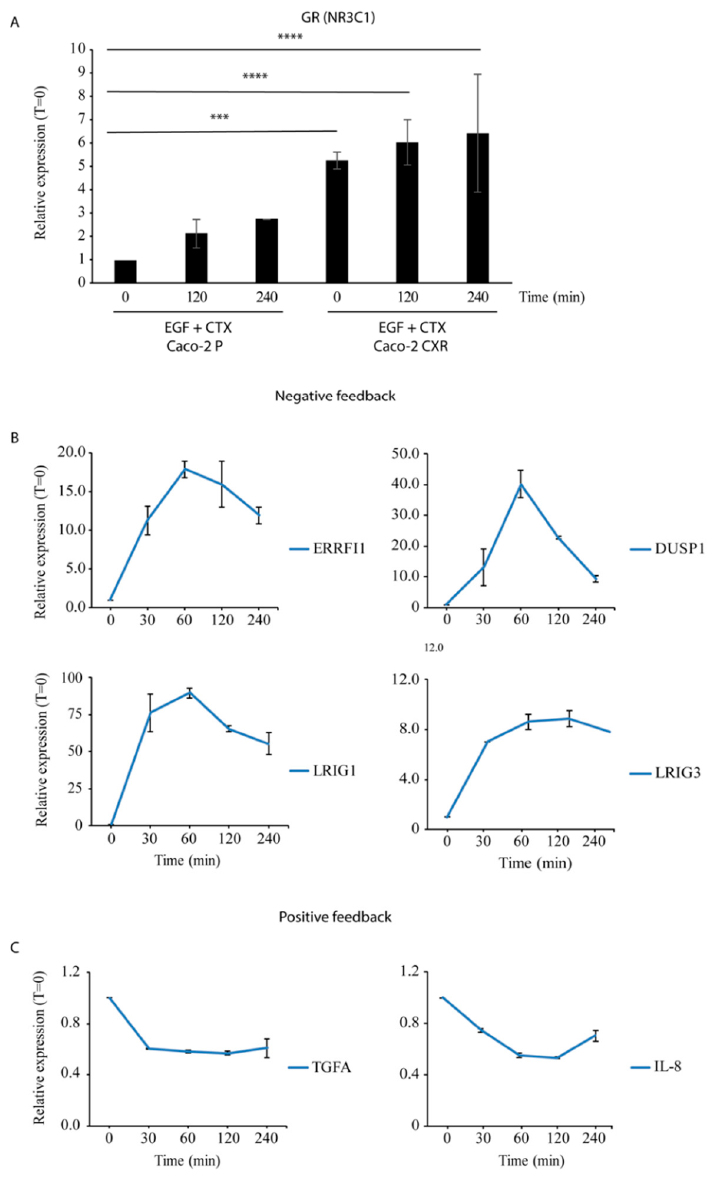
Figure 3. Dexamethasone suppresses EGFR positive regulators and boosts negative feedback loops in cetuximab (CTX) resistant cells. ( A ) Caco-2 Parental (P) and Caco-2 cetuximab resistant (CXR) cells were treated with cetuximab (CTX, 2 µ g / mL) in combination with EGF (20 ng / mL) for 120 and 240 min. Notably, Caco-2 CXR displayed a higher basal level of GR mRNA compared to Caco-2 P counterpart. We also observed an increase in GR mRNA production in both Caco-2 P and Caco-2 CXR, compared to time 0. The ordinary one-way ANOVA with Dunnett’s multiple comparisons test was applied to evaluate statistical changes in relation to Parental cells to time 0. **** p < 0.0001 and *** p < 0.0005. ( B ) Caco-2 CXR cells were pre-treated with dexamethasone (DEX, 1 µ M) for 10 min, and stimulated with a combination of CTX (2 µ g / mL) and EGF (20 ng / mL) at di ff erent time points (30, 60, 120 and 240 min). qPCR analysis was performed in triplicate for EGFR negative feedback loops (ERRFI1, DUSP1, LRIG3 and LRIG1). mRNA levels displayed a strong increase after 30 min of stimulation, with the maximum hit after 60 min. Apart from DUSP1, high expression level of these genes was maintained over the time course (up to 8 hours). ( C ) mRNA levels of EGFR positive feedback genes (TGFA and IL-8) are depicted. Following DEX stimulation, a decrease in the mRNA production of TGFA and IL-8 was observed already at 30 min and was maintained all over the time course.